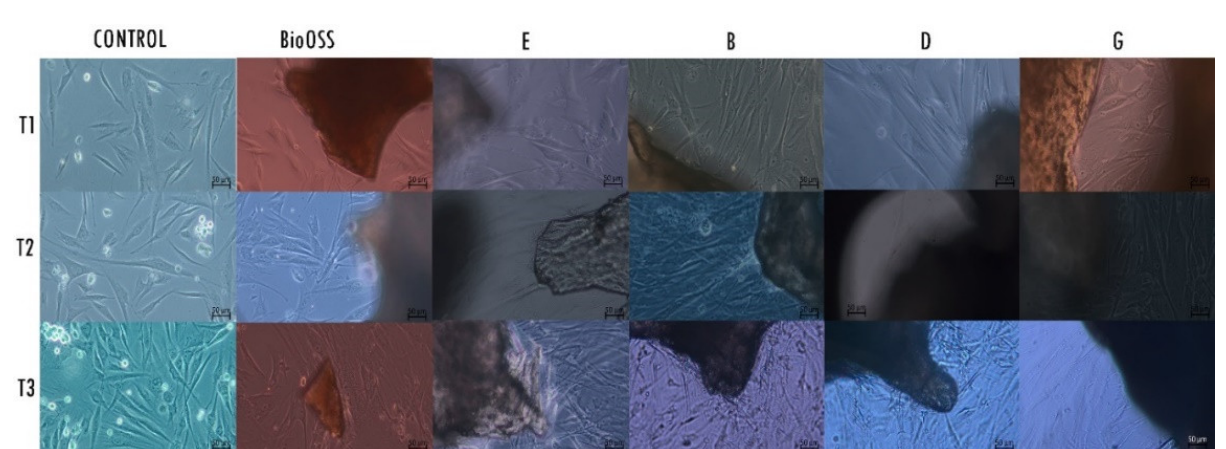
Figure 3. Contrast-phase light microscopy images of HPLF cells with the examined materials and the negative control at the different examined times; magnification 20×.